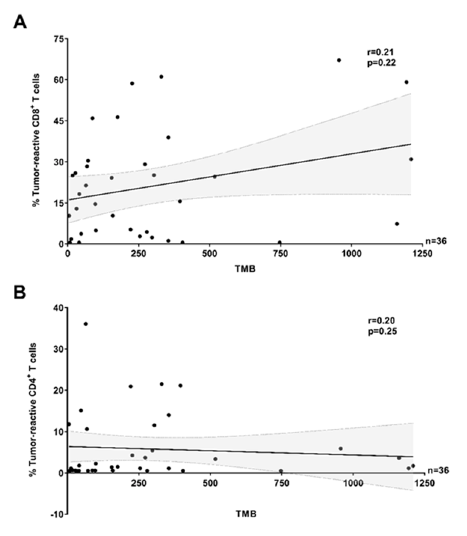
Figure 3. Antitumor-reactivity of TILs and tumor mutational burden in melanoma (pooled data). The proportion of tumor-reactive ( A ) CD8 + and ( B ) CD4 + TILs was not correlated (Spearman r = 0.21, p = 0.22 and Spearman r = 0.20, p = 0.25, respectively) to tumor mutational burden (TMB) (pooled MM clinical cohorts). The solid lines and dotted lines represent the best-fit regression line and 95% confidence interval, respectively. ( A , B ) In all panels, the recognition of TILs (Y TILs and REP TILs) was tested against separate sets of autologous tumor cells (TCLs, TCLs + IFN γ or FTDs) and only the highest value reported. T cells were considered reactive if positive for at least one of TNF, IFN γ , or CD107a, minus